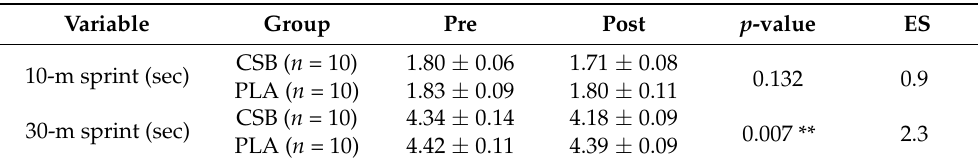
( p = 0.909, ES: 0.4) (Table 3). Table 2. Change of 10- and 30-m sprint following combined creatine and sodium bicarbonate supplementation. Variable Group